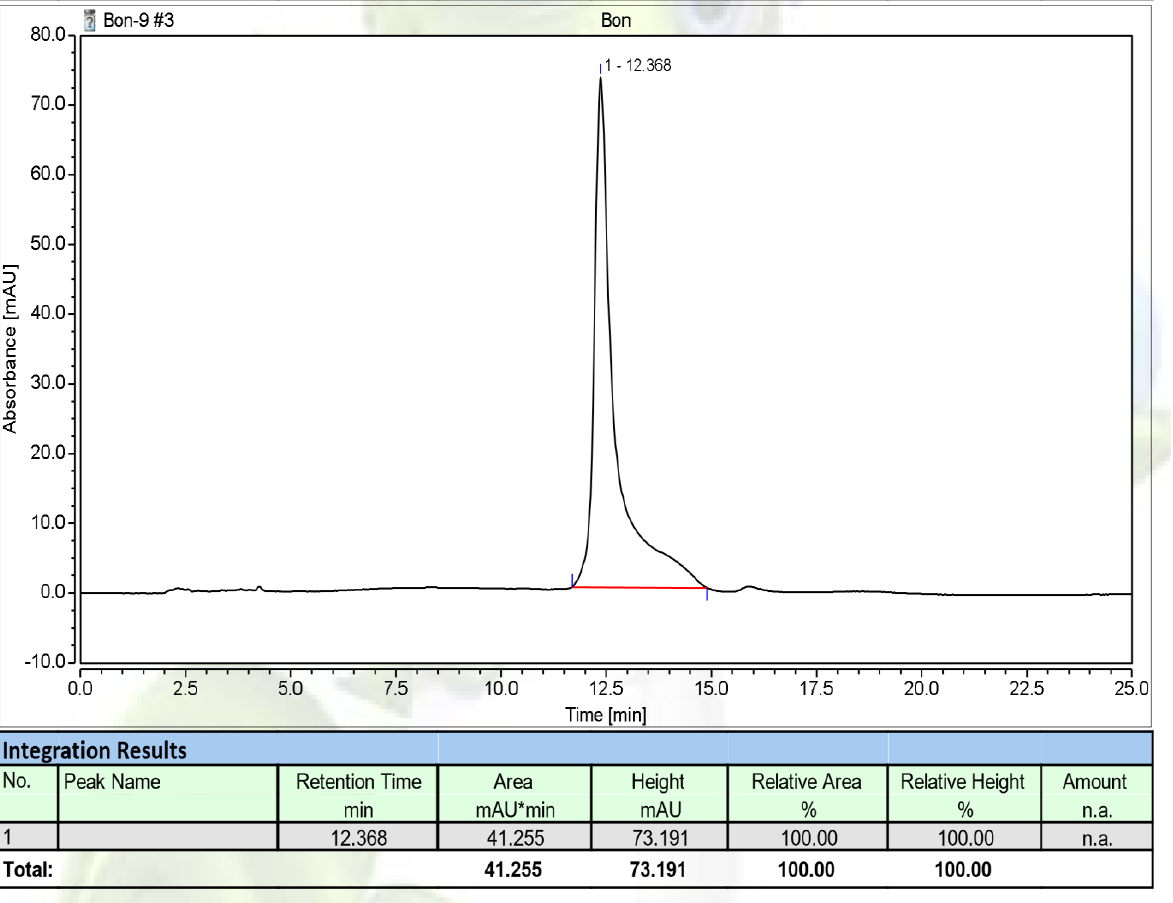
Figure 4. Extraction and purification of bioactive prodigiosin (PG) from fermentation with S. marcescens TNU01. The liquid medium, containing cassava wastewater fermented with S. marcescens TNU01 in a 14 L-bioreactor system ( a ), was subjected to layer separation using ethyl acetate ( b ), and the crude PG was further isolated in an open silica column ( c ) to obtain purified PG ( d ).